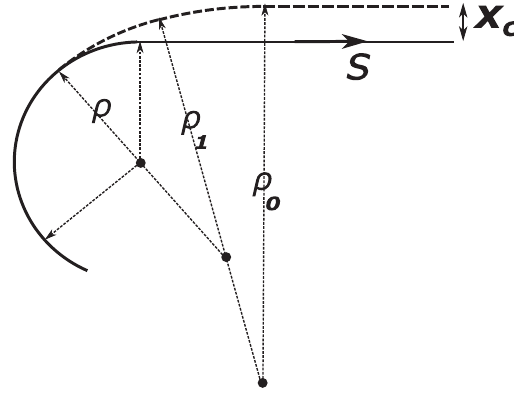
FIG. 8. Illustration of the difference between the particle orbit and the design orbit at the dipole exit. The bold line represents the design orbit, and the thick dashed line represents the particle trajectory. The curvature of the particle trajectory increased step by step. Initially, ρ is the design curvature, then ρ 1 ¼ 2 ρ and ρ ¼ 3 ρ , and finally exits the field region. The three large dots 0 correspond to the origins of the three curvatures. FIG. 6. Δ p